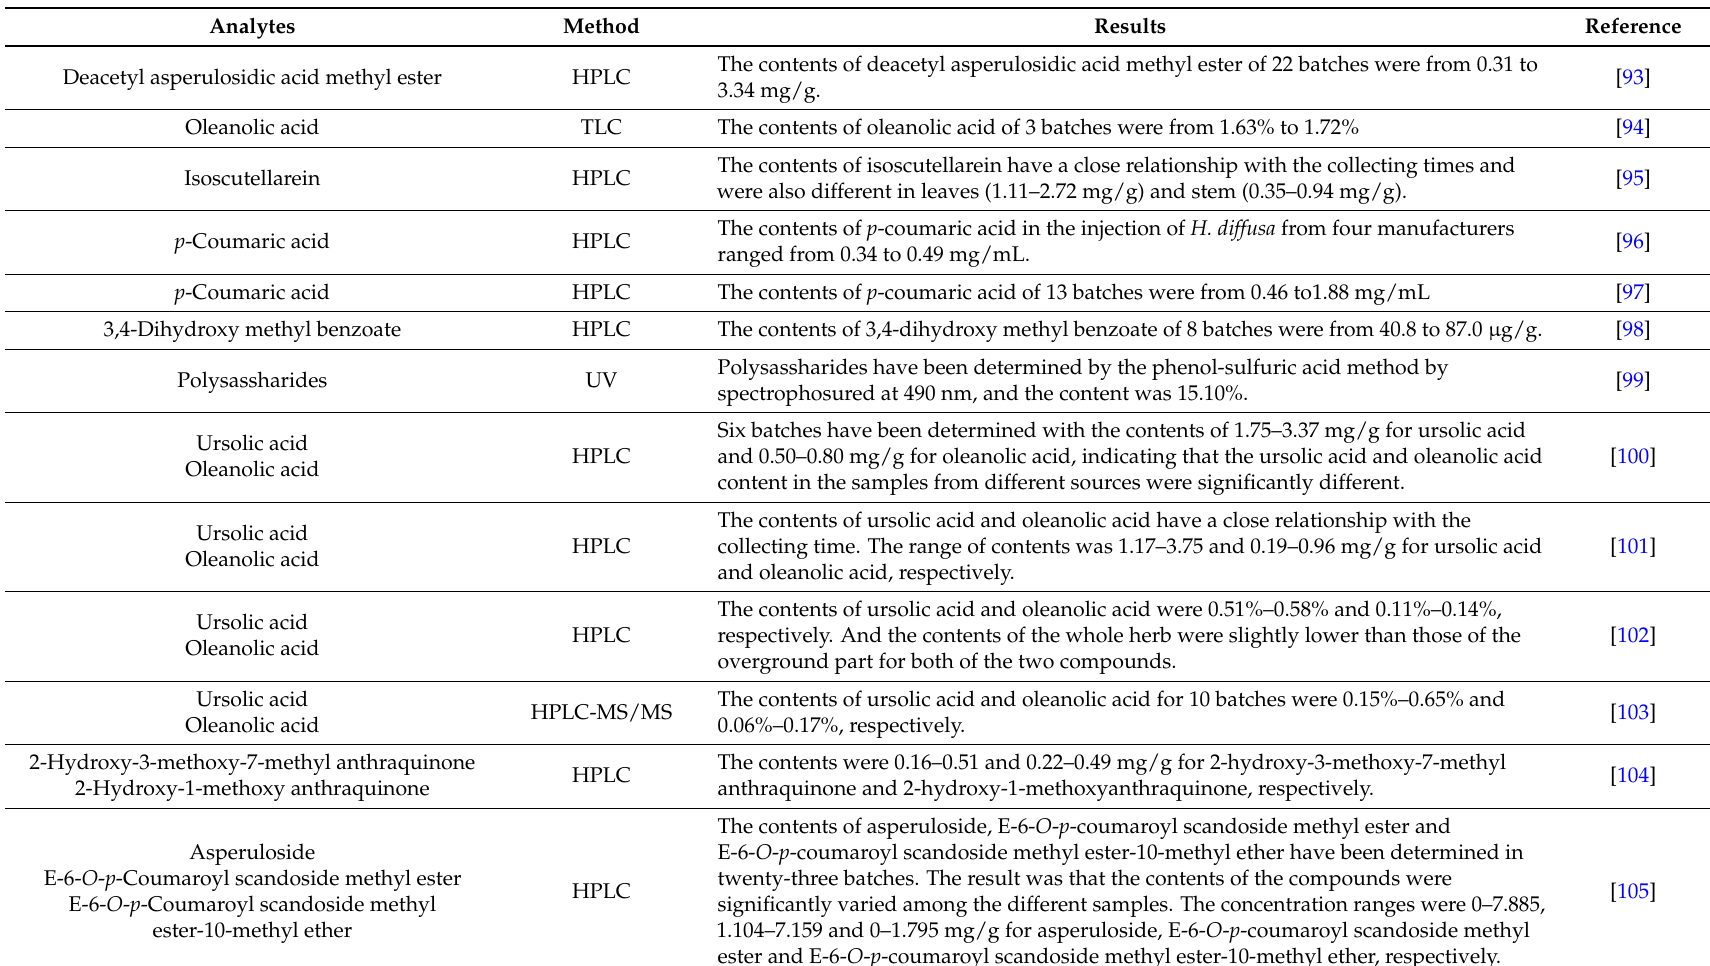
Table 3. Quantitative analysis for the quality control of H. diffusa